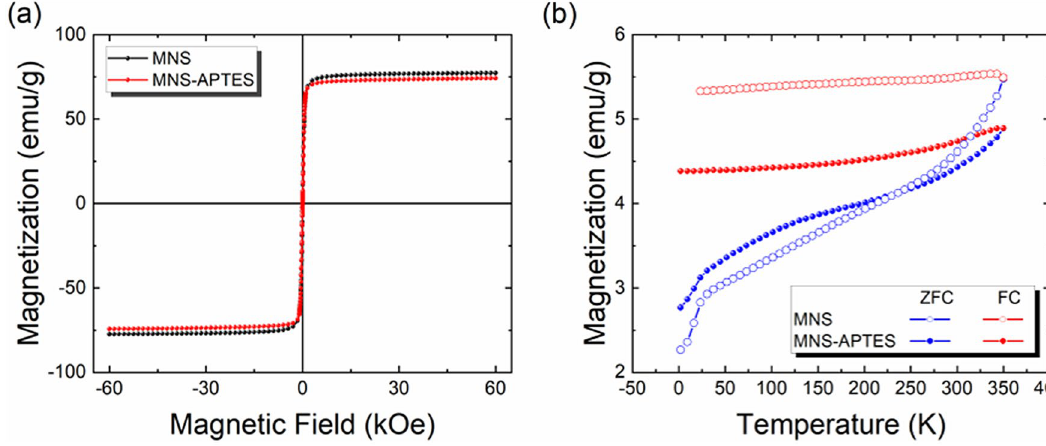
Figure 4. ( a ) Room-temperature M-H curves of MNS and MNS-APTES and ( b ) temperature-dependent FC-ZFC magnetization curves of MNS and MNS-APTES.